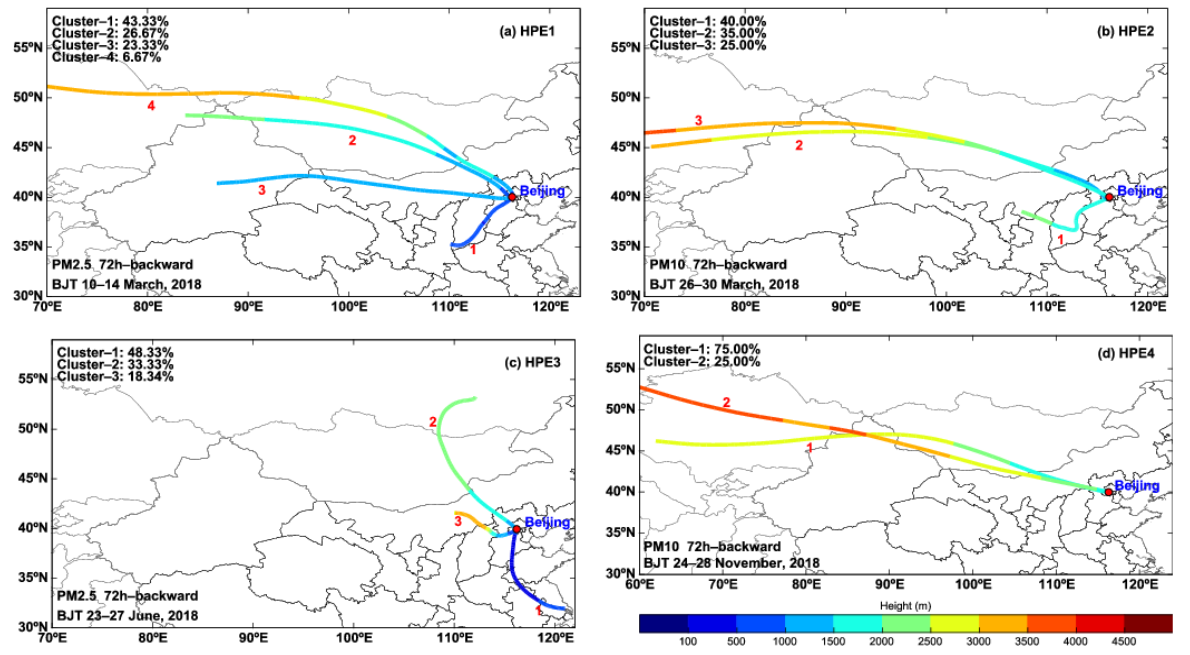
Figure 2. Mean 72 h backward trajectories of trajectory clusters in Beijing during heavy pollution episodes (HPE1, 2, 3, and 4) in 2018.